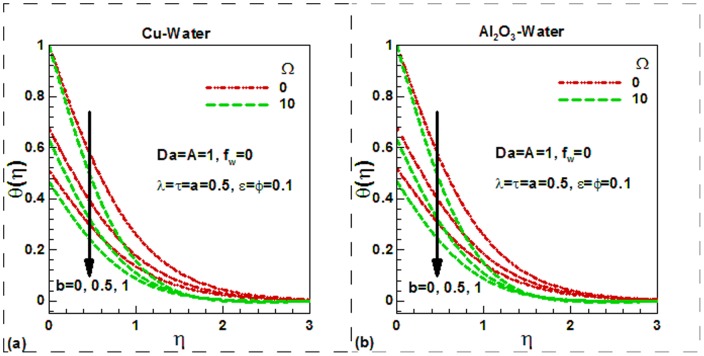
Effects of thermal slip and dimensionless frequency on dimensionless temperature for (a) Cu-water and (b) Al2O3-water nanofluids.